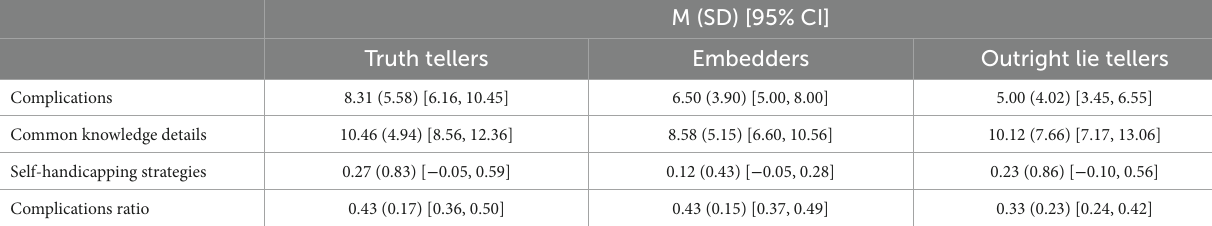
TABLE 2 Descriptives of the dependent variables according to the veracity